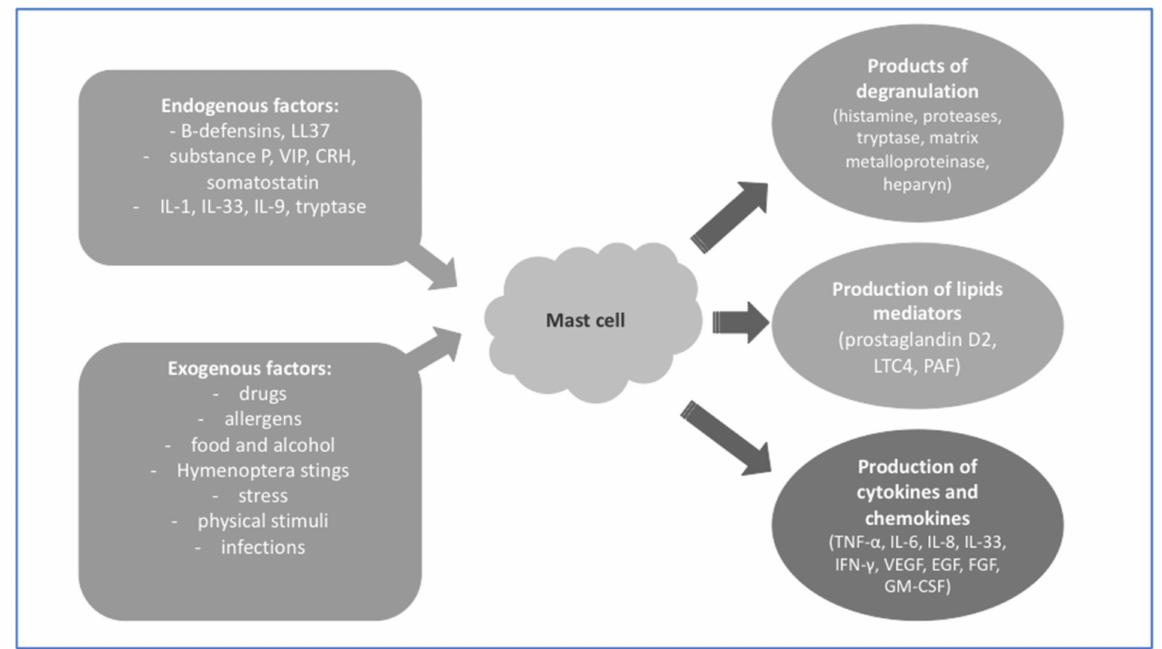
Figure 1. Activity of MCs